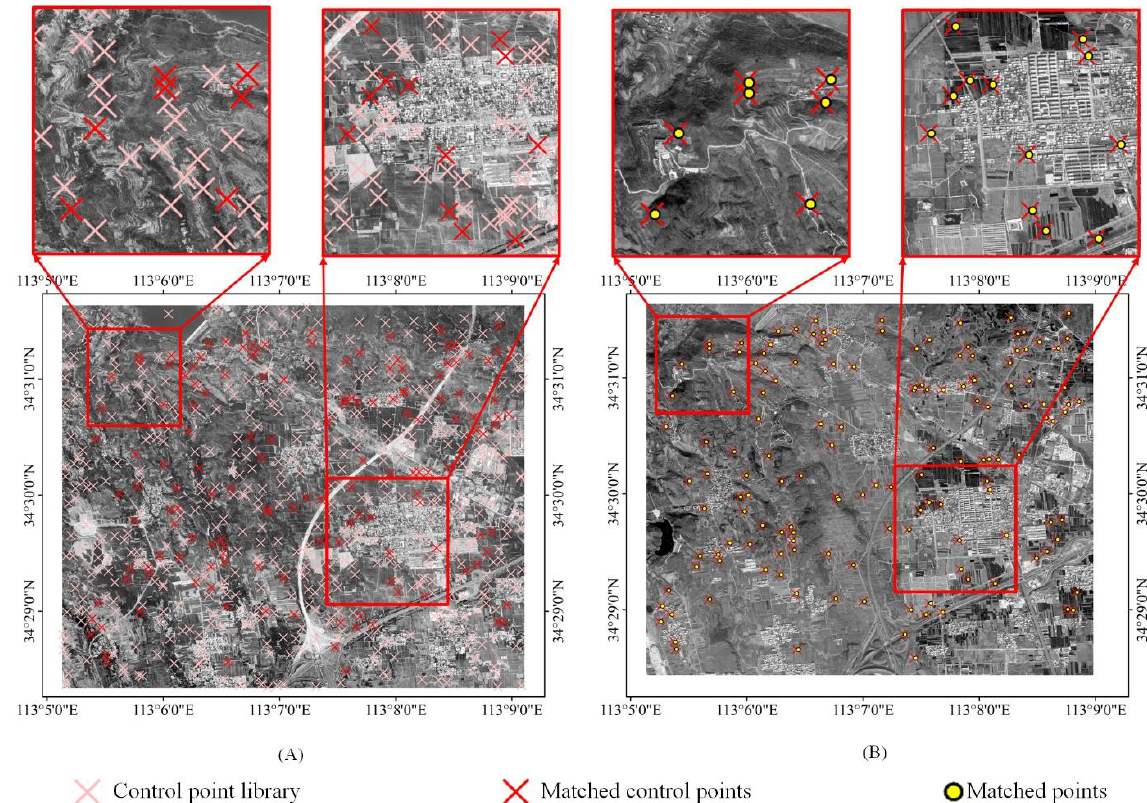
Figure 5. The results of Google image matching. (A) is GCPs image, and (B) is the Google image with (163m, 152m) offset.